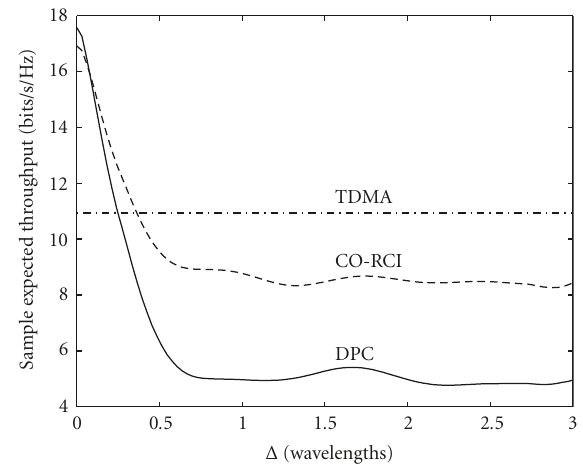
Figure 2: Sample expected throughput (SET) as a function of delay for a network with parameters N t = N r = 4, K = 5, and P = 10 given various transmit precoding schemes in the spatially white, Jakes’ channel model with a normalized Doppler frequency of f d = 0 .